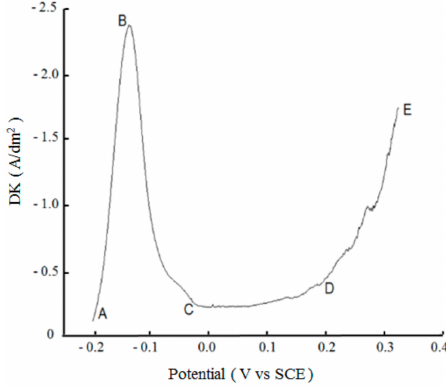
Figure 8. Anodic polarization curve of the nickel